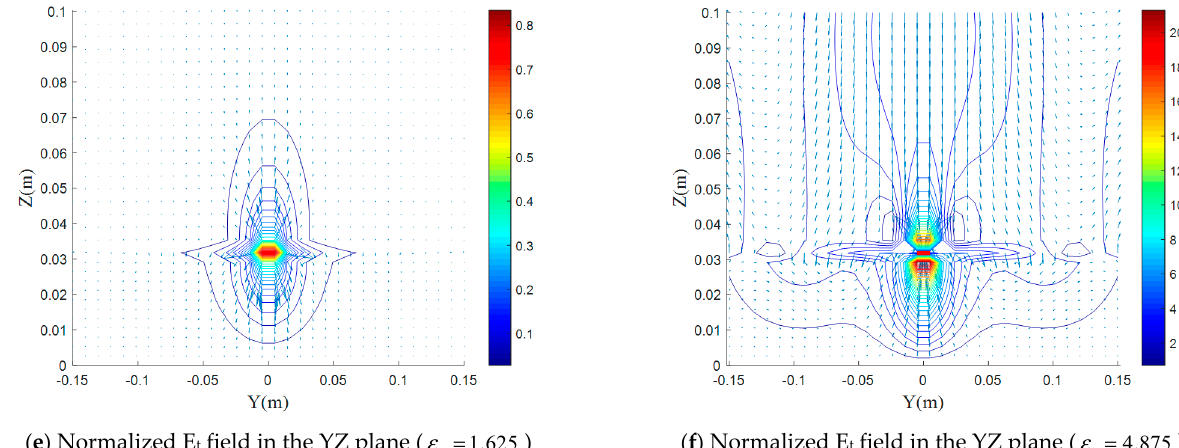
ε with 253 . = ε , 1 = μ and 1 = μ in the z t z t